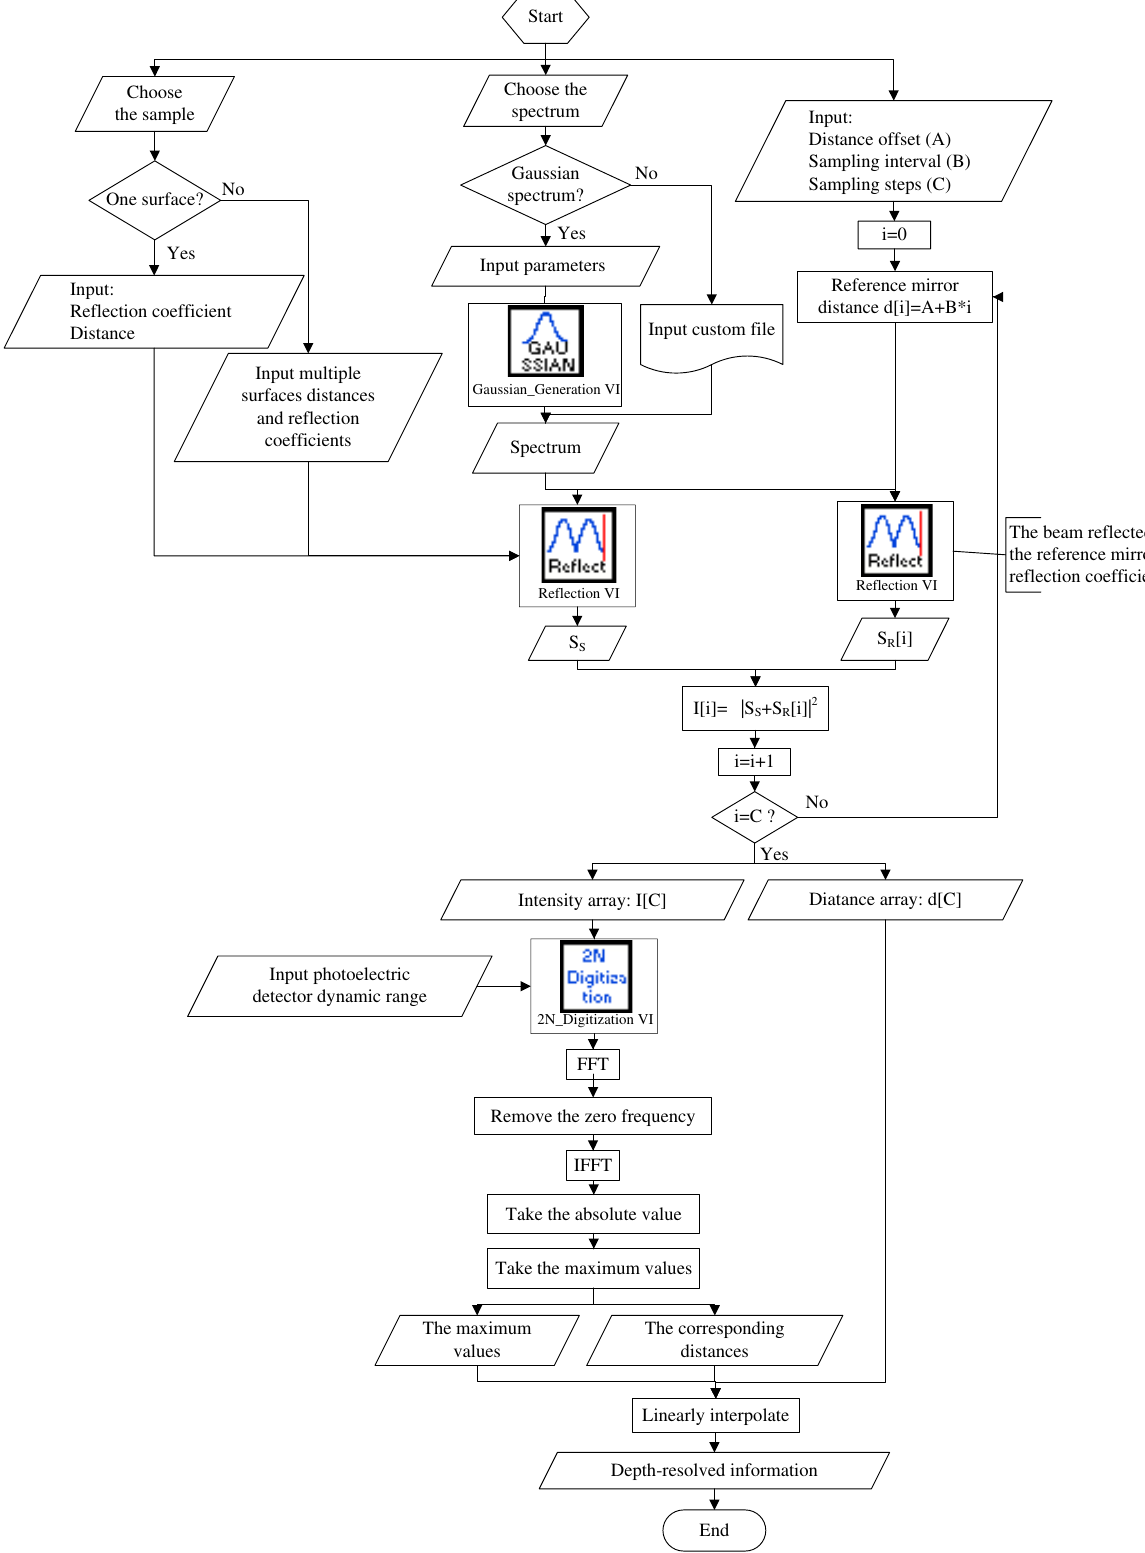
Fig. 7. The °owchart of the TD-OCT A-scan